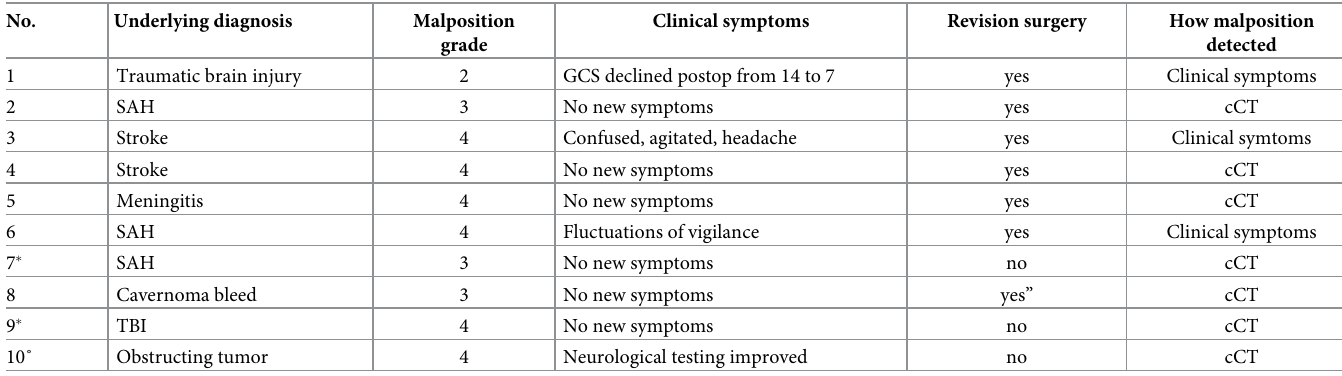
Table 1. Clinical summary of VP shunt malposition in grade 2 with revision surgery and all grade 3 or 4 patients.